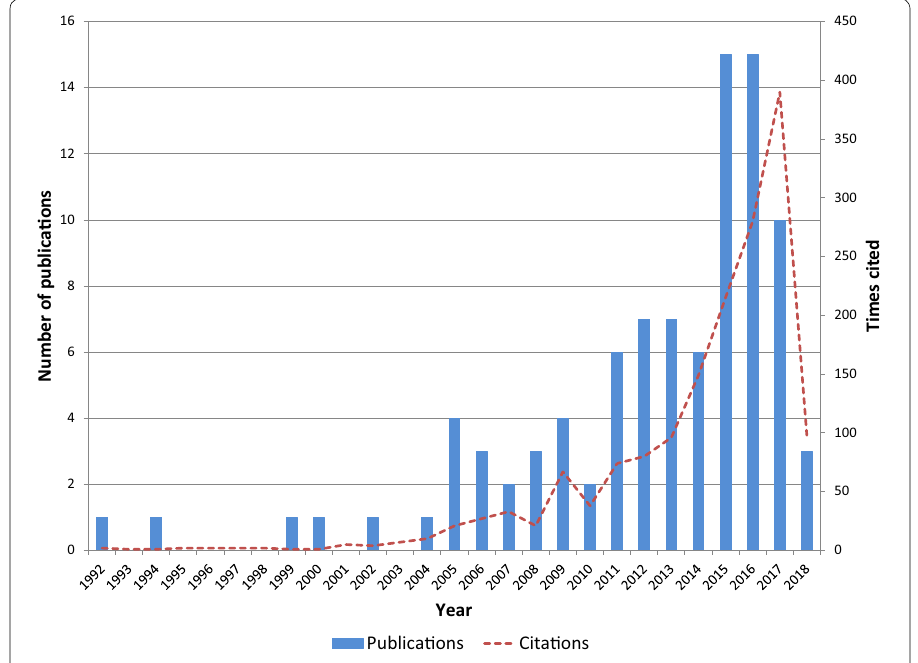
Fig. 1 Number of publications and citations per year (status on 11 June